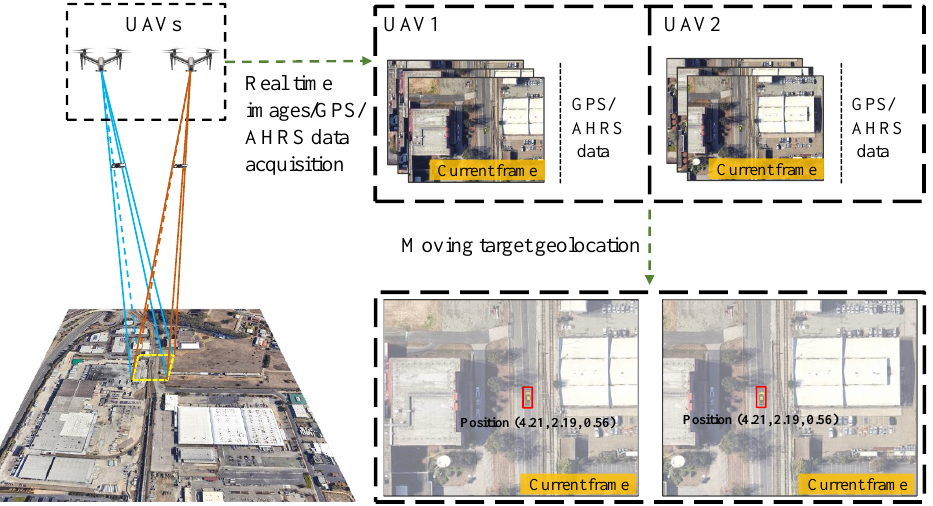
Figure 1. Demonstration that the proposed framework realizes online ground moving-target geoloca- tion using dual